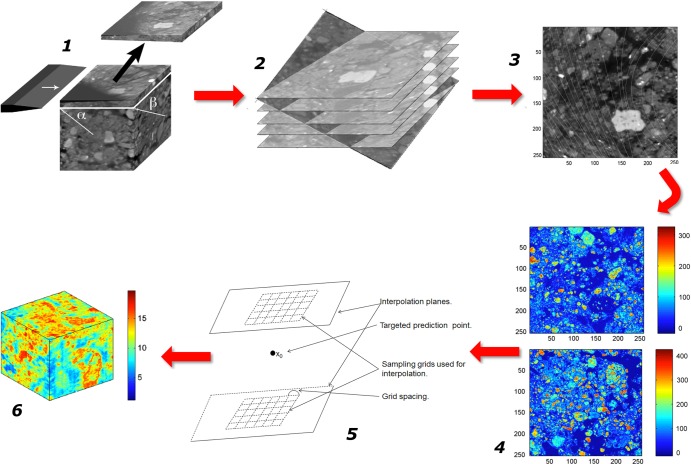
Schematic diagram of the successive steps in the 2D–3D interpolation method proposed by Hapca et al. (2011, 2015). (1) Illustration of a typical method to isolate a layer from a soil cube, with a microtome blade. The cut may be at angles α and β, respectively, with the x–y plane in the x and y directions, respectively, resulting in layer surfaces that are not strictly parallel to each other, (2) rotation of the chemical analysis plane within the 3D CT image, (3) Reconstituted CT image of the soil surface. The dotted lines correspond to the limits of the different masks applied to the successive layers during the zonation process, (4) Spatial distribution, measured with SEM–EDX, of silicon in the top and bottom soil surfaces of an individual slice through the soil sample, (5) schematic representation of the interpolation layers and the corresponding sampling grids for the selection of the interpolation points, (6) 3D prediction of the silicon distribution in soil sample.